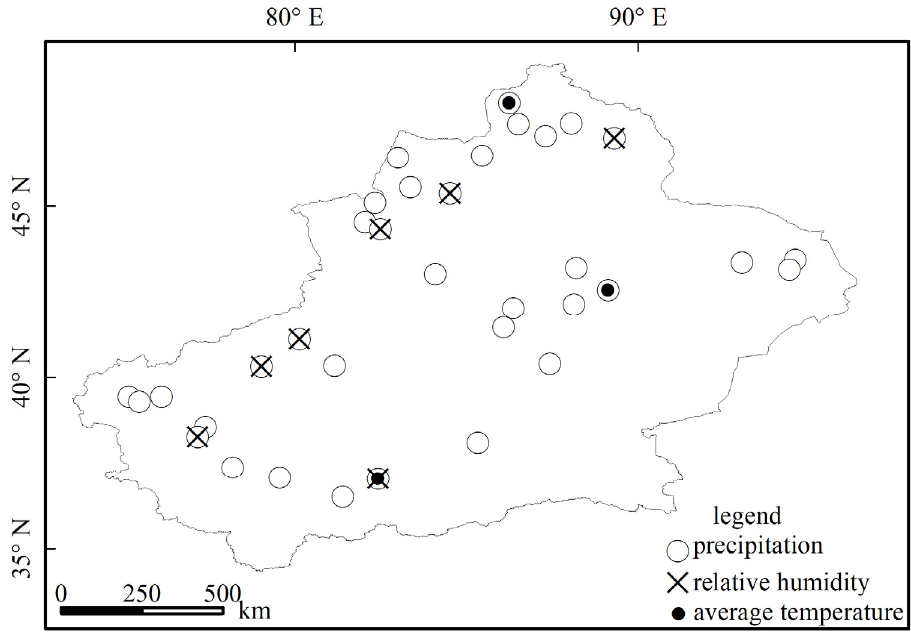
Figure 6. Absolute value of the contribution rate of main influencing factors > 15%.